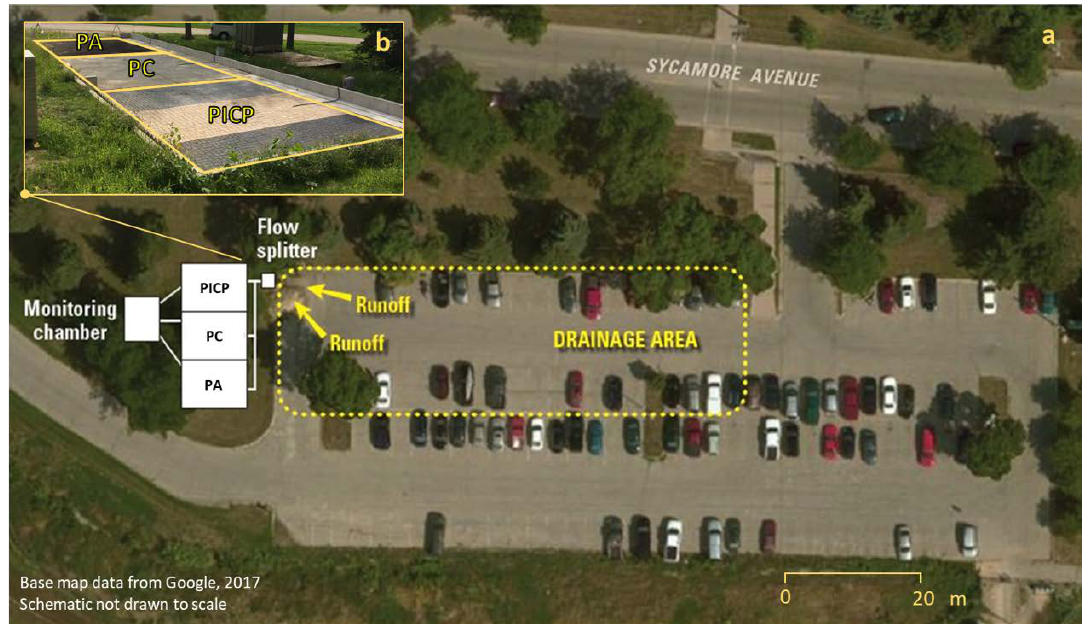
Figure 1. Images of the permeable pavement research facility in Madison, Wisconsin showing ( a ) schematic of drainage area and orientation of permeable pavements, and ( b ) photograph of the permeable interlocking pavers (PICP), pervious concrete (PC), and porous asphalt (PA) test plots. Adapted from Selbig and Buer [1].